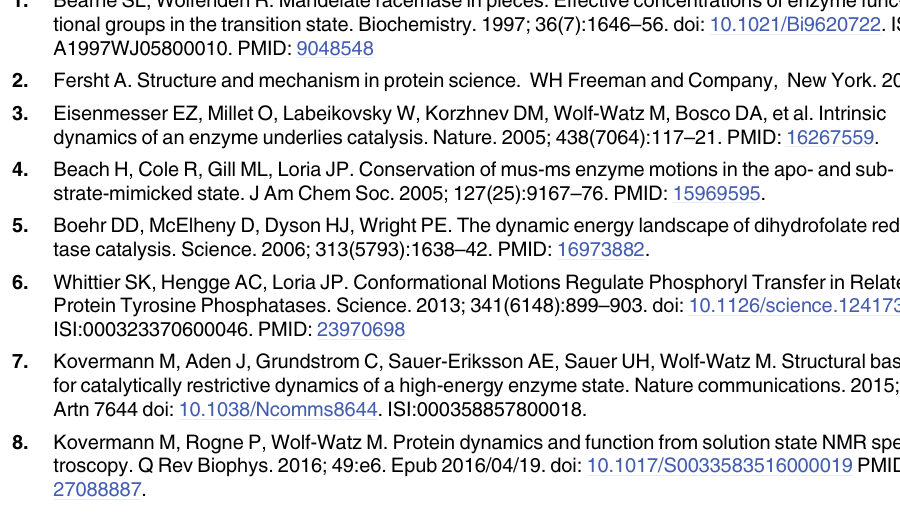
variants. ( A ) T163C. ( B ) G10V. ( C ) G56C. ( D ) eco variants. ( A ) I116G. ( B ) R36S+11a.a. ( C ) eco